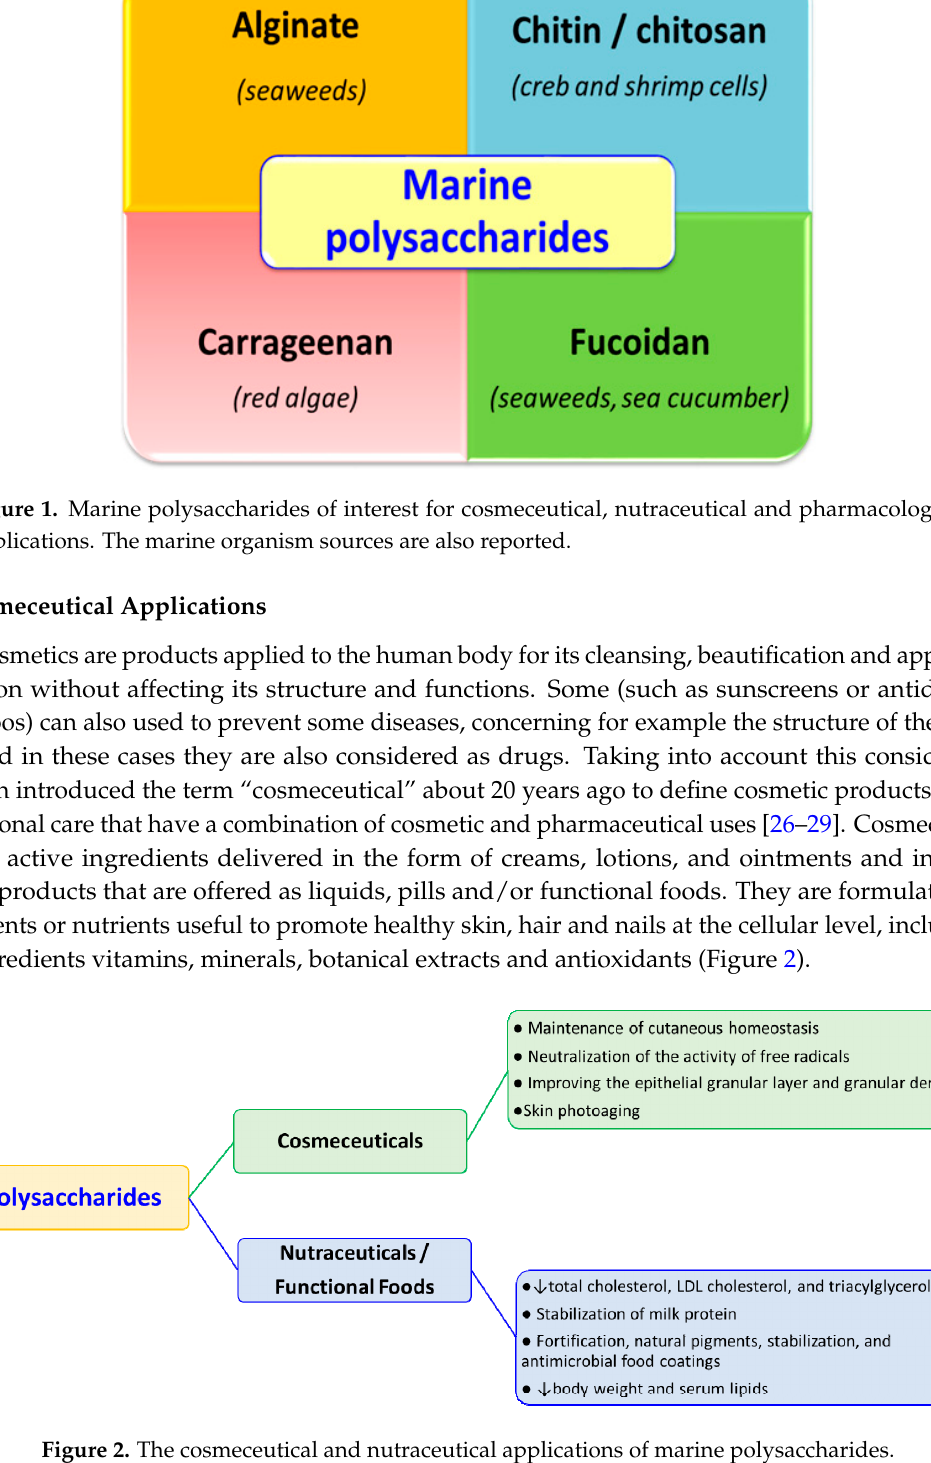
Figure 2. The cosmeceutical and nutraceutical applications of marine polysaccharides.